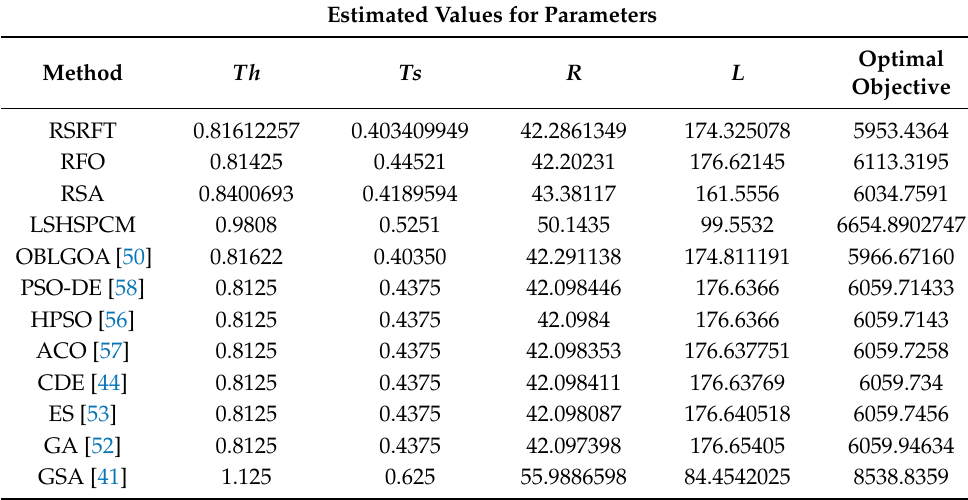
Table 3. The value of the estimated parameters using RSRFT and other approaches to solve the PVD